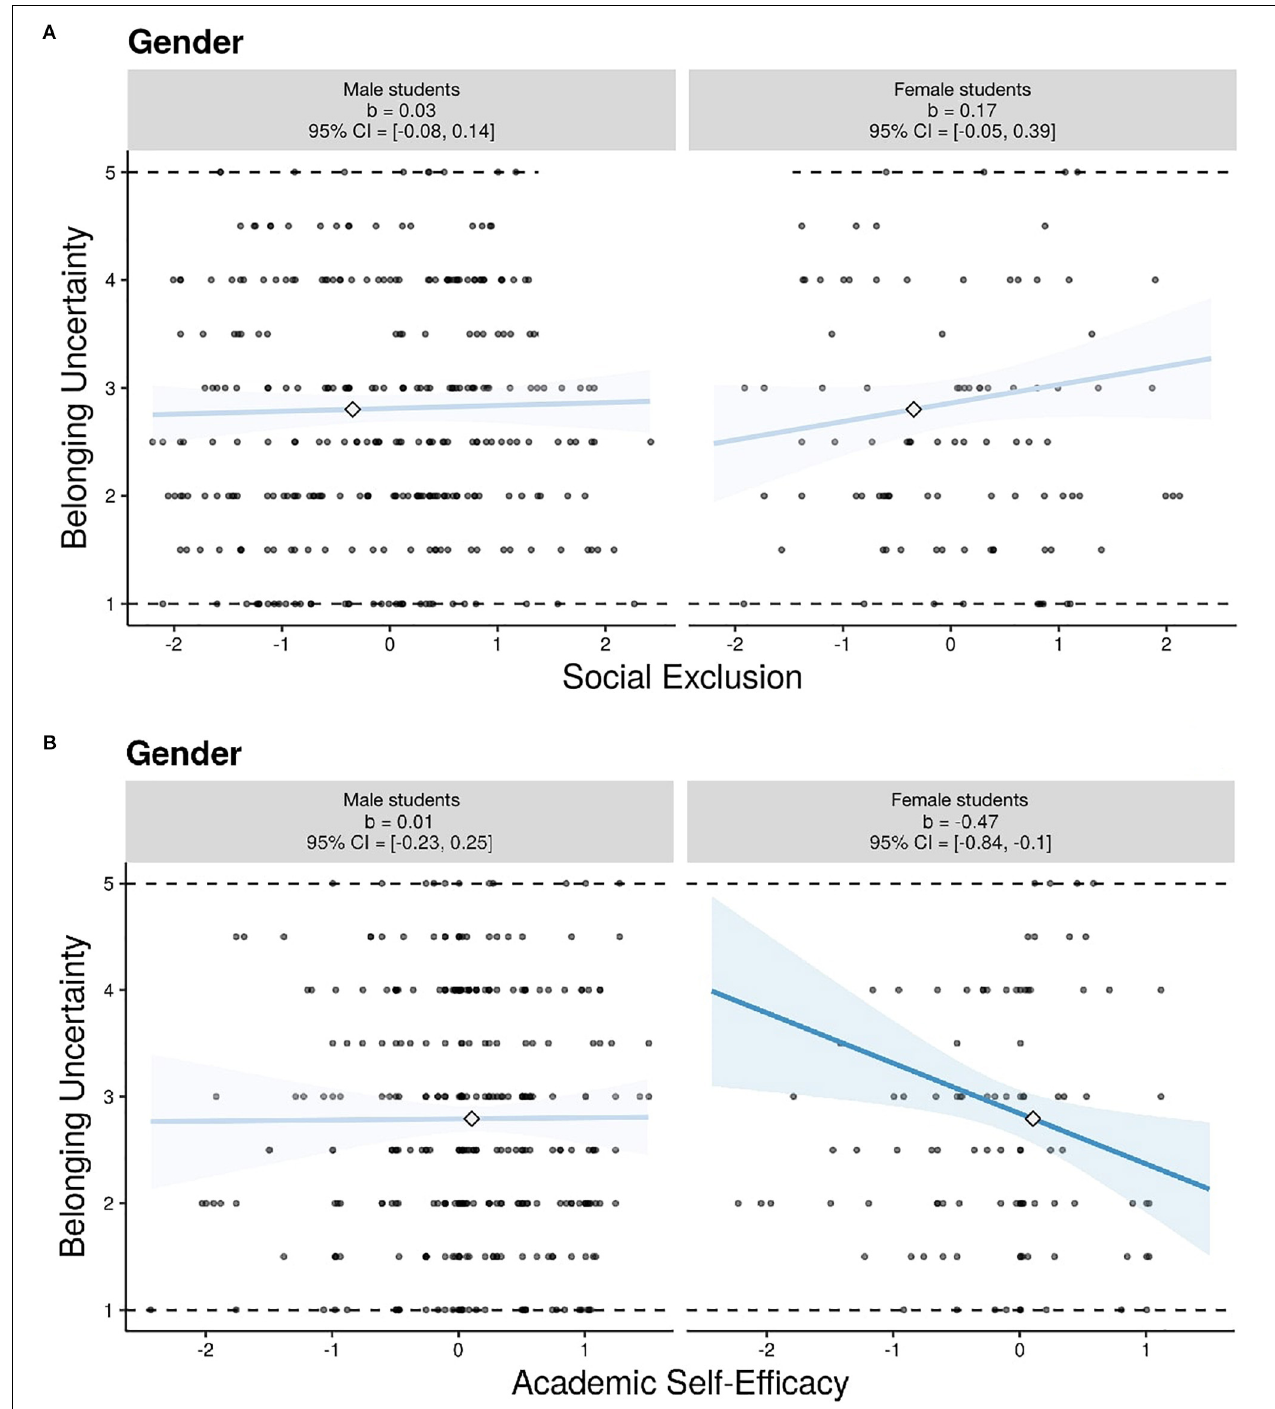
FIGURE 1 | (A) Simple slopes graphs depicting the relationship between social exclusion and belonging uncertainty. Academic self-efficacy, relative potential, the initial level of belonging uncertainty, academic performance, gender, academic self-efficacy X gender, and relative potential X gender were entered as covariates. (B) Simple slopes graphs depicting the relationship between academic self-efficacy and belonging uncertainty. Social exclusion, relative potential, the initial level of belonging uncertainty, academic performance, gender, social exclusion X gender, and relative potential X gender were entered as covariates. In each panel, simple slopes are displayed for both levels of the moderator. Each graphic shows the computed 95% confidence region (shaded area), the observed data (gray circles), the minimum and maximum values of the outcome (dashed horizontal lines), and the crossover point (diamond). Regression coefficients ( b ) differ from the ones depicted in Table 3 due to full information maximum likelihood estimation (FIML) within Mplus. CI = confidence interval. Figures were produced using the interActive data visualization tool (McCabe et al., 2018).